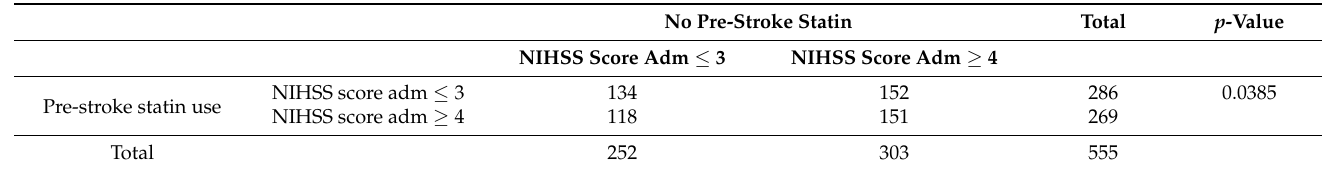
Table 4. McNemar test for a binary matched-pair contingency table of mild neurological